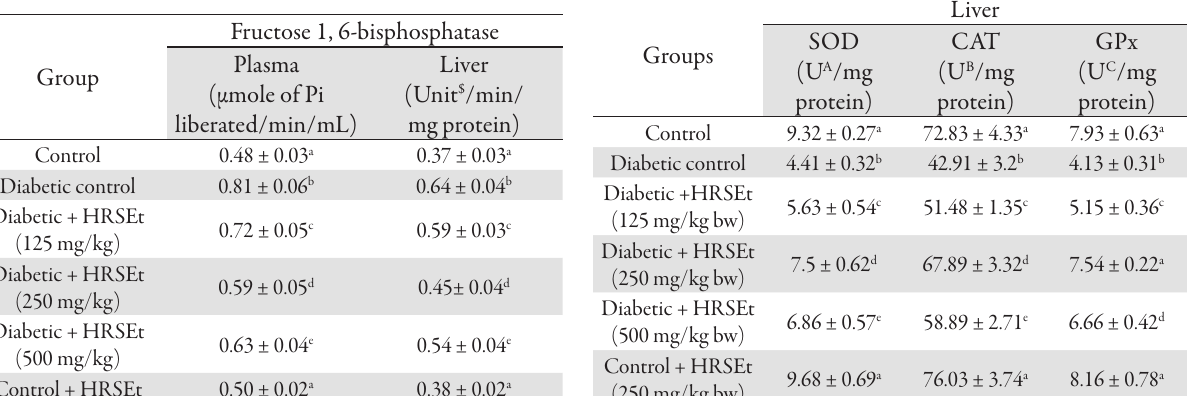
Tab. 4. Effect of HRSEt on the levels of fructose1, 6-bisphosphatase in plasma and tissues of control and experimental rats